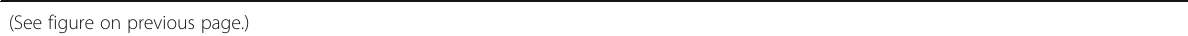
(Additional file 6: Figure S5) and VE-cadherin (Fig. 2) were assembled at the cellular periphery forming tight boarders between inter-cellular membranes. Treatment with RSPO3 enhanced actin polymerization generating notably thicker actin fibers (Additional file 5: Figure S4), and disrupted β -catenin (Additional file 6: Figure S5) and VE-cadherin at inter-cellular boarders, forming large inter-endothelial gaps (Fig. 2a, b).